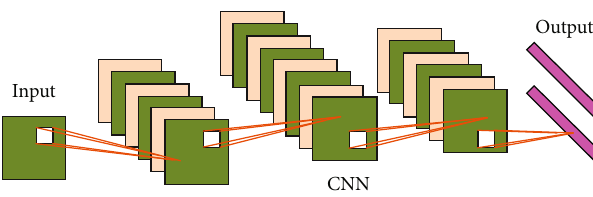
Figure 2: The basic structure of the convolutional neural